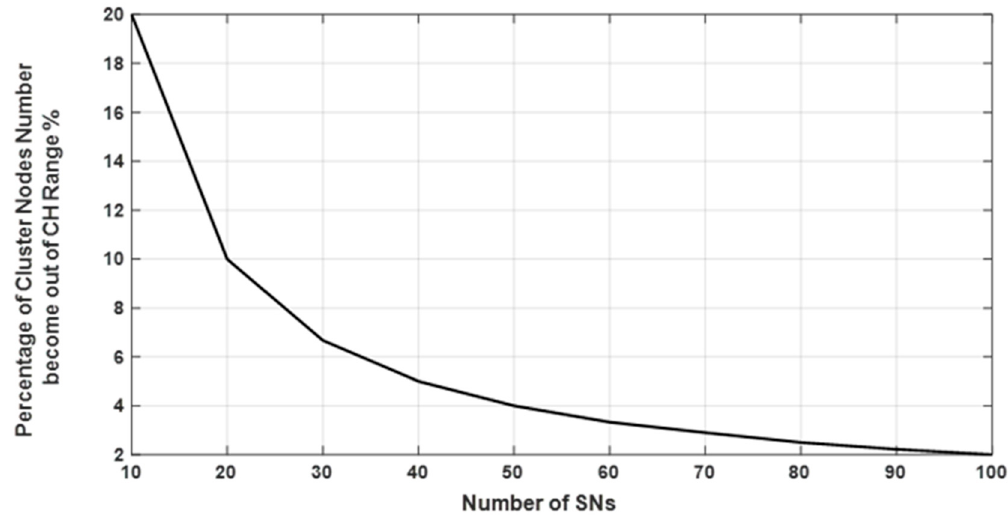
Figure 8 . The percentage number of nodes that lost their connections with CH after CH movement.